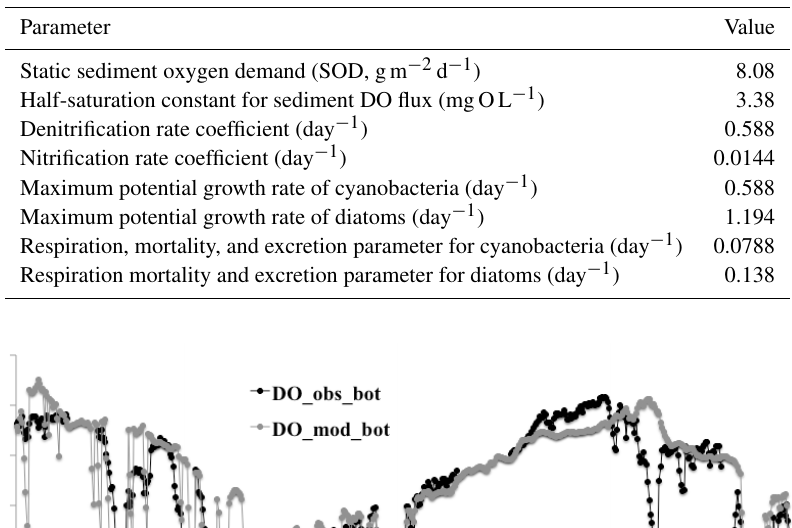
Table 3. Values of key parameters for DO production and consumption in DYRESM-CAEDYM, chosen through autocalibration.